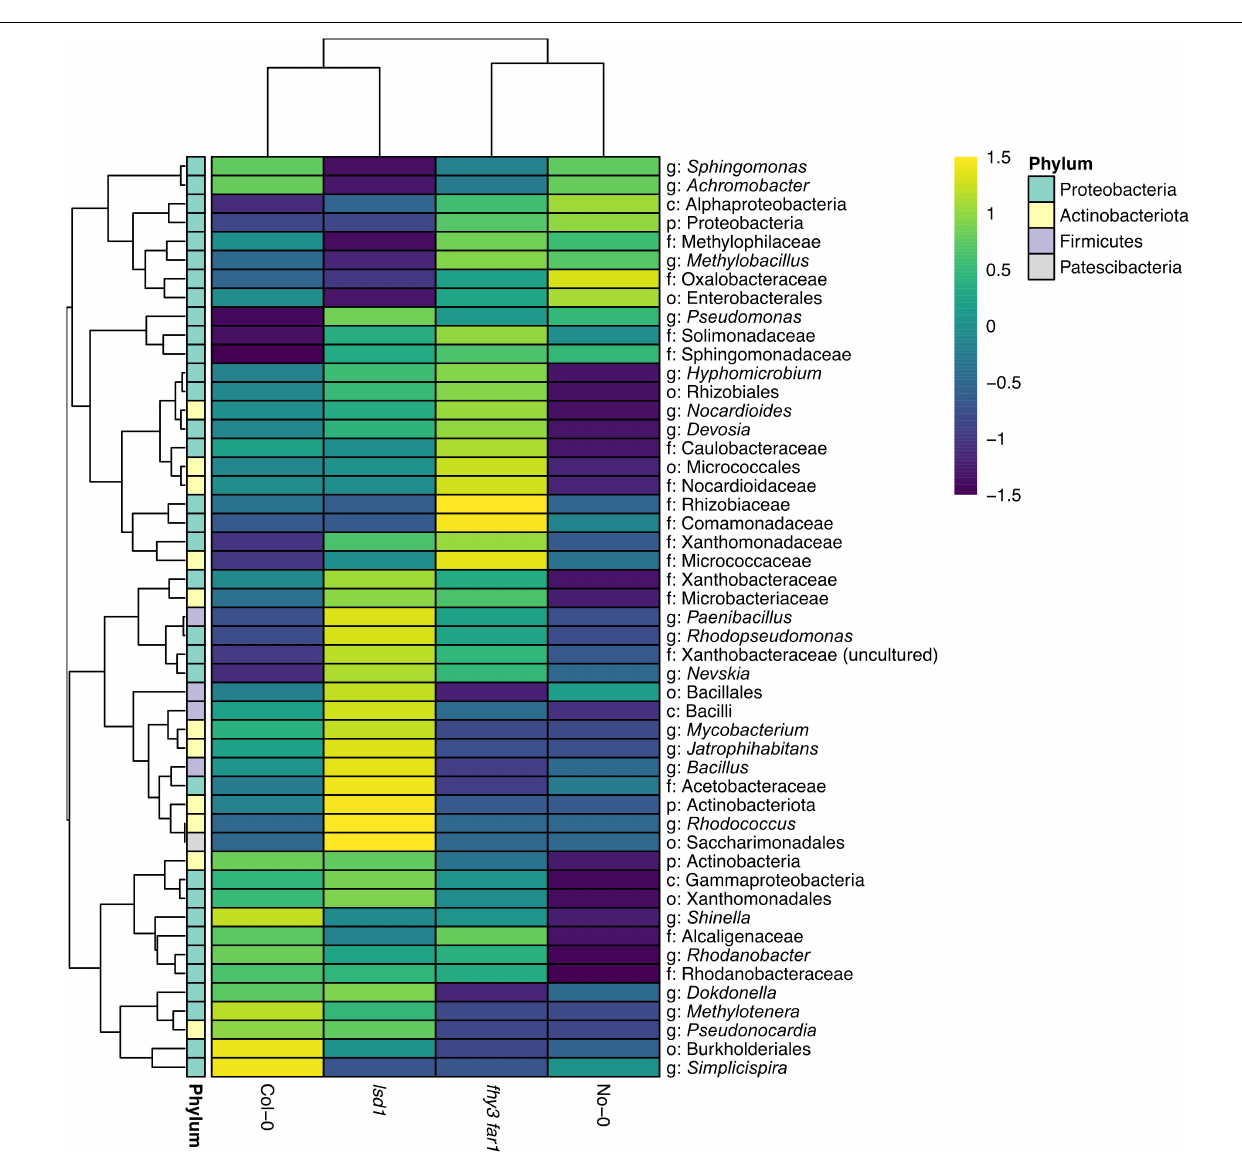
FIGURE 4 | Hierarchical clustering of the relative abundance of core phyllospheric phylotypes. Euclidean clustering of the log 10 relative abundances of the 49 core bacterial phyllospheric phylotypes, classified to at least the phylum level, present in both WT ecotypes and both SA signaling mutants. Phylotypes were classified using mothur (v.1.44.3) (Schloss et al., 2009) and the SILVA database (v.138) (Quast et al., 2013) from bacterial 16S rRNA sequences present in the phyllosphere microbiomes of four A. thaliana genotypes 35